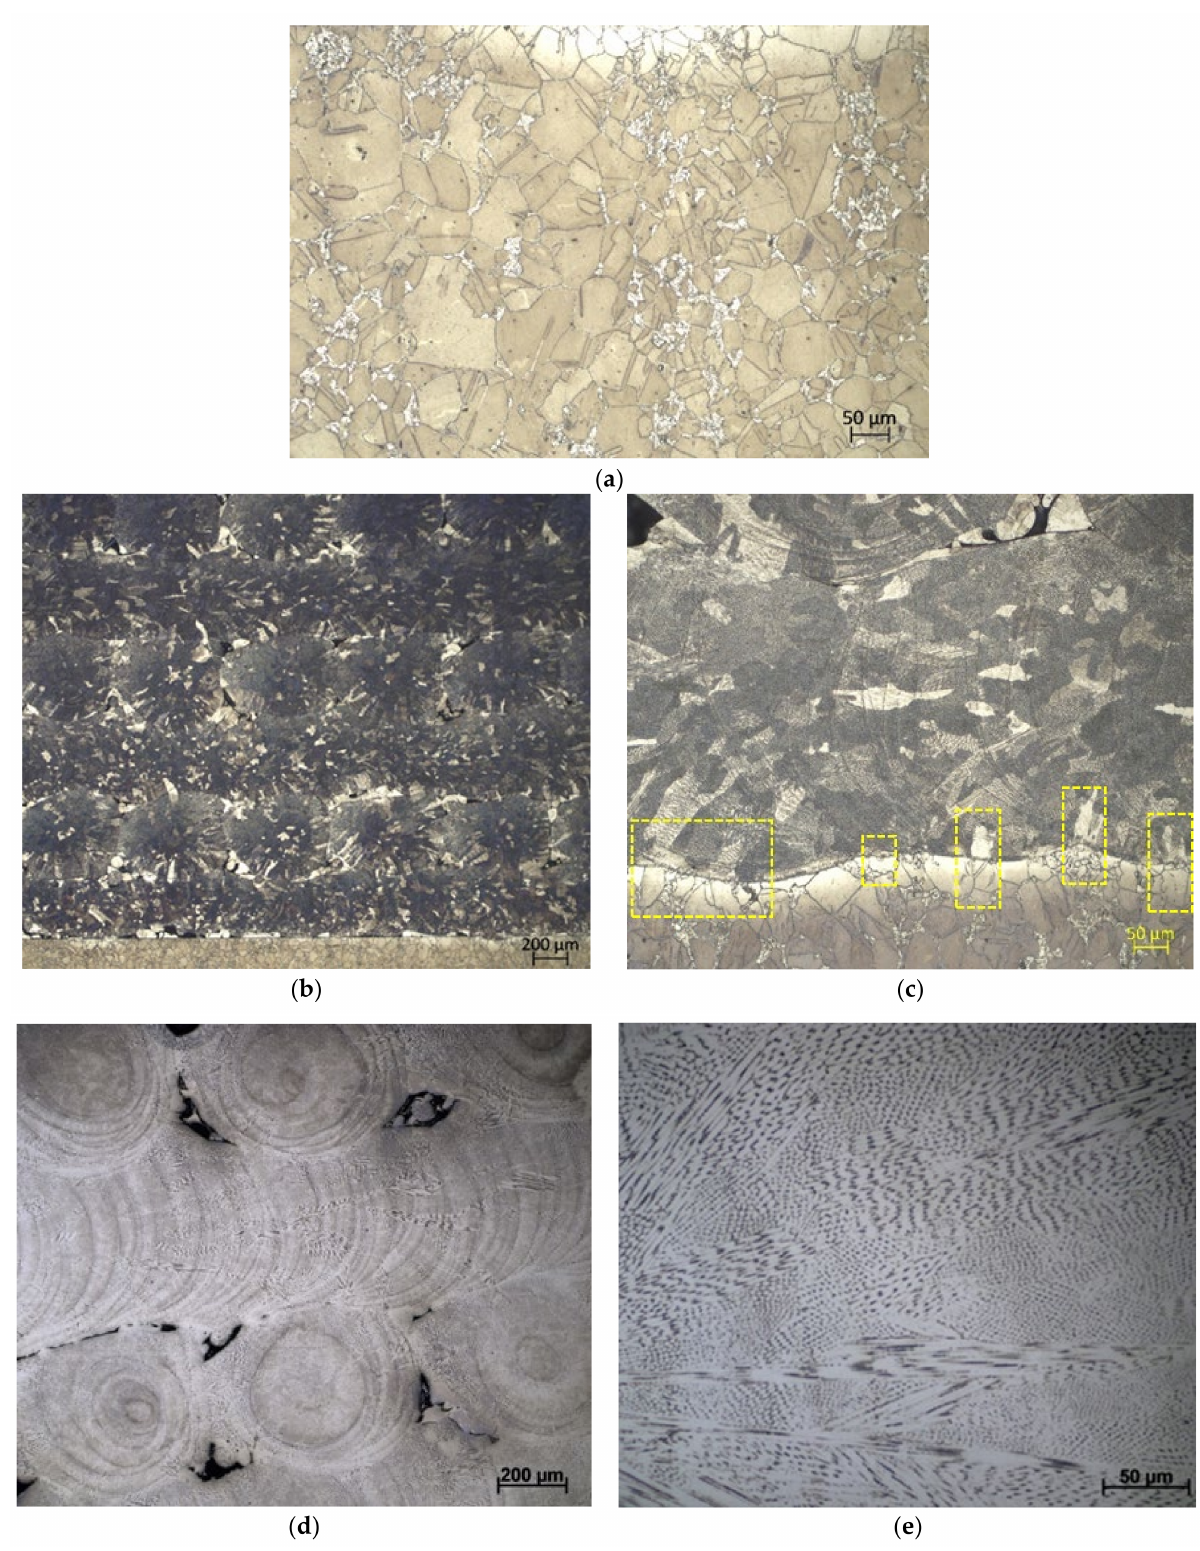
Figure 3. Microstructural analysis of the layers deposited by LMD: ( a ) substrate, ( b ) deposited-layer microstructure revealed by 10% oxalic acid electrolytic etching, ( c ) deposition/substrate interface highlighting the epitaxy, ( d ) deposited-layer microstructure revealed by 40% NaOH water solution electrolytic etching, and ( e ) deposited layer with higher magnification highlighting dendritic growth. Yellow boxes belong to discrete regions of analyses (see